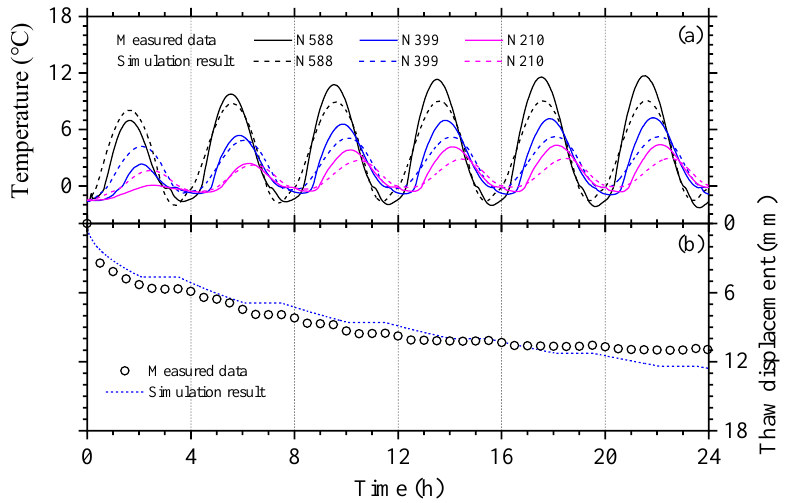
Figure 2. Measured and simulated results of temperature ( a ) and vertical deformation ( b ) of the soil specimen.